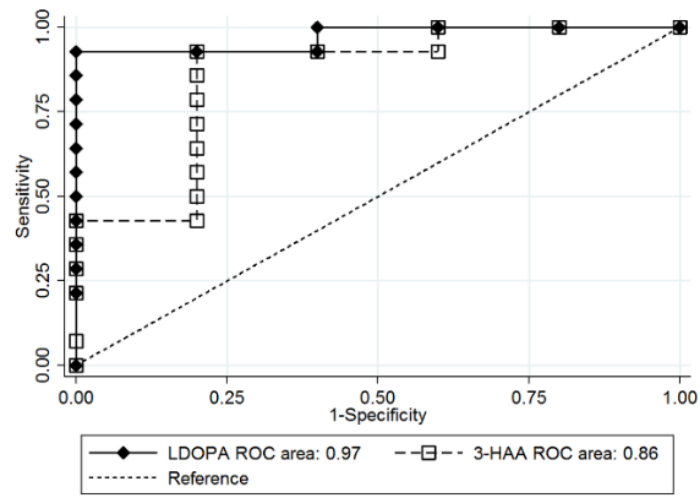
Figure 3. Prognostic performance of L-dihydroxyphenylalanine (L-DOPA) and 3-hydroxyanthranilic acid (3-HAA) measured at 3 months after bariatric surgery. Using L-DOPA and 3-HAA measured at 3 months after surgery, receiver operating characteristic (ROC) curves were generated. The superior prognostic performance of L-DOPA and 3-HAA continued until 3 months postoperatively, and they showed the best discrimination ability in predicting type 2 diabetes (T2D) remission 12 months after bariatric surgery.